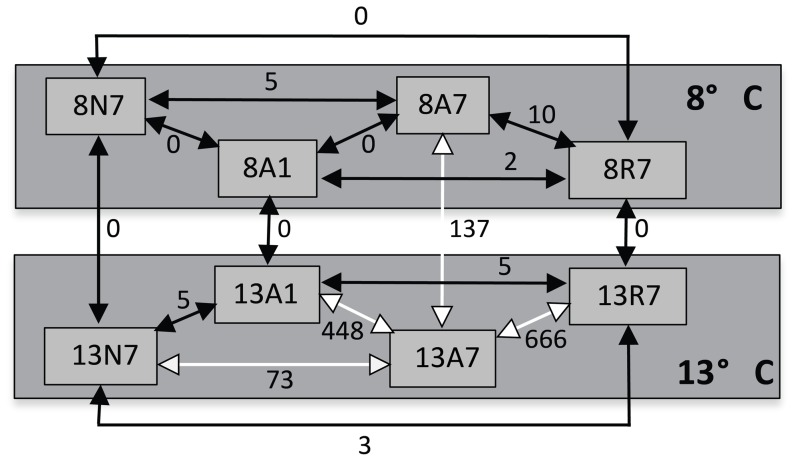
The hybridisation design employed in this experiment.Each double-headed arrow represents two 2-dye-swapped microarrays contrasting the indicated treatments. Each RNA sample was taken from a different carp specimen and thus represented a biologically independent sample. A total of 32 arrays and 64 RNA samples were used (12 arrays were used to compare specimens at 8°C, a further 12 compared those at 13°C and 8 arrays compared 8 with 13°C). Thus, each condition was sampled with 8 independent specimens. The numbers adjacent to the arrows indicate the number of differentially expressed genes detected for the indicated contrast (FDR <5%). The white arrows indicate the contrasts possessing the majority of differentially expressed genes, all of which were connected to the A7 treatment (anoxia for 7 days).